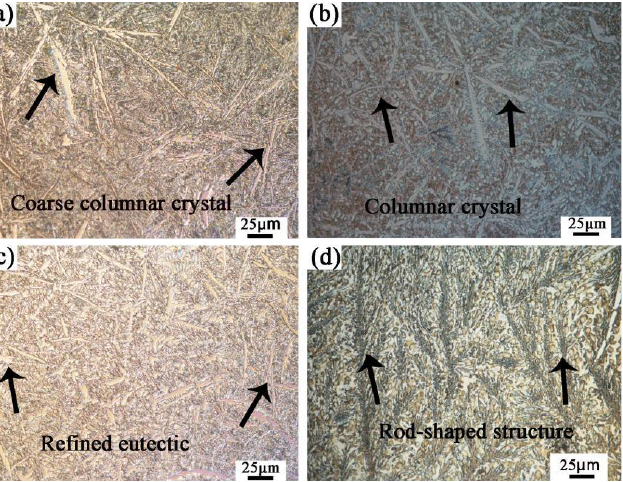
Figure 2. The microstructures of composite coatings of different heat−treatment temperatures: ( a ) 25 °C; ( b ) 500 °C; ( c ) 600 °C; ( d ) 700 °C. ( a ) 25 ◦ C; ( b ) 500 ◦ C; ( c ) 600 ◦ C; ( d ) 700 ◦